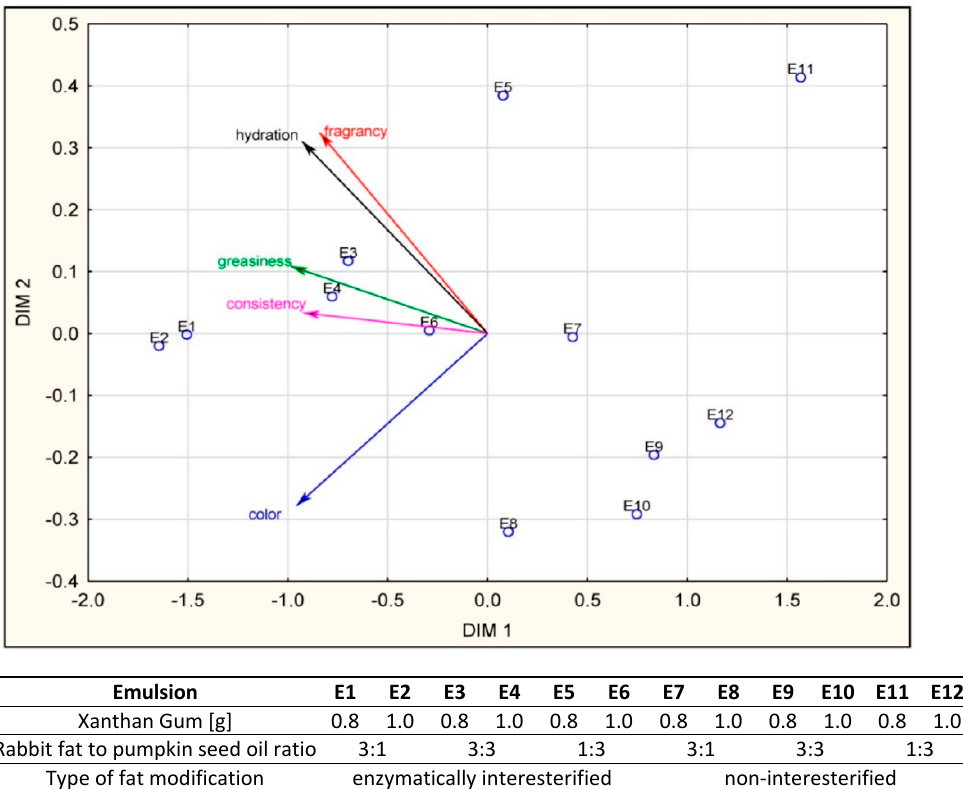
Figure 7. Emulsion perception map (E1-E12) in a system of variables sensory characteristics in the opinion of consumers.